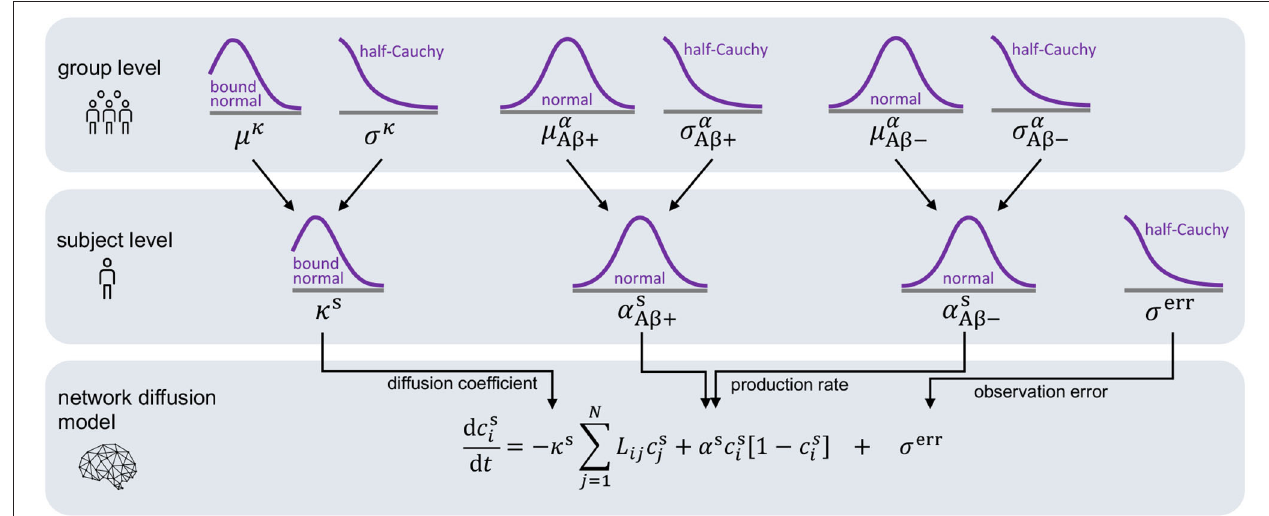
FIGURE 3 | Hierarchical Bayesian inference. Hierarchical structure and prior assumptions for Bayesian inference approach.